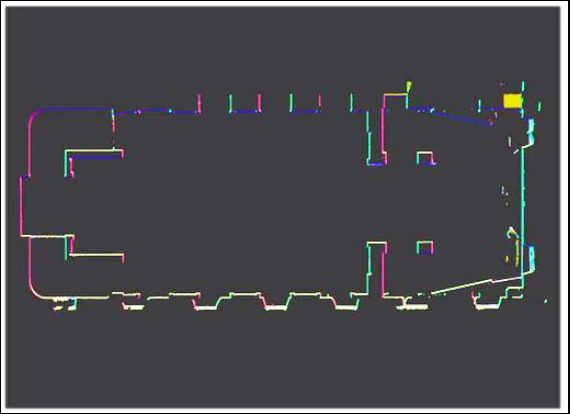
Figure 7. Plan track obtained from the point cloud Source: Municipality of Milan